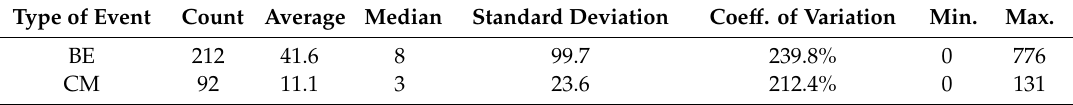
Table 4. Basic descriptive statistics for the number of partnerships, depending on the type of promotional event. Type of Event Count Average Median Standard Deviation Coe ff . of Variation Min. Max. BE 212 41.6 8 99.7 239.8% 0 776 CM 92 11.1 3 23.6 212.4% 0 131 Source: own